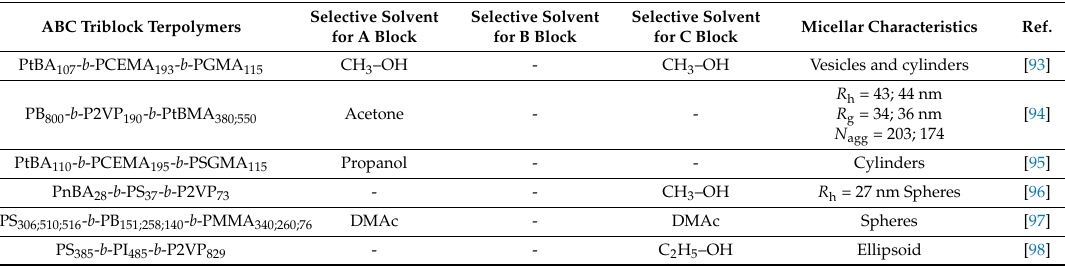
Table 5. Self-assembly of linear ABC triblock terpolymers in polar